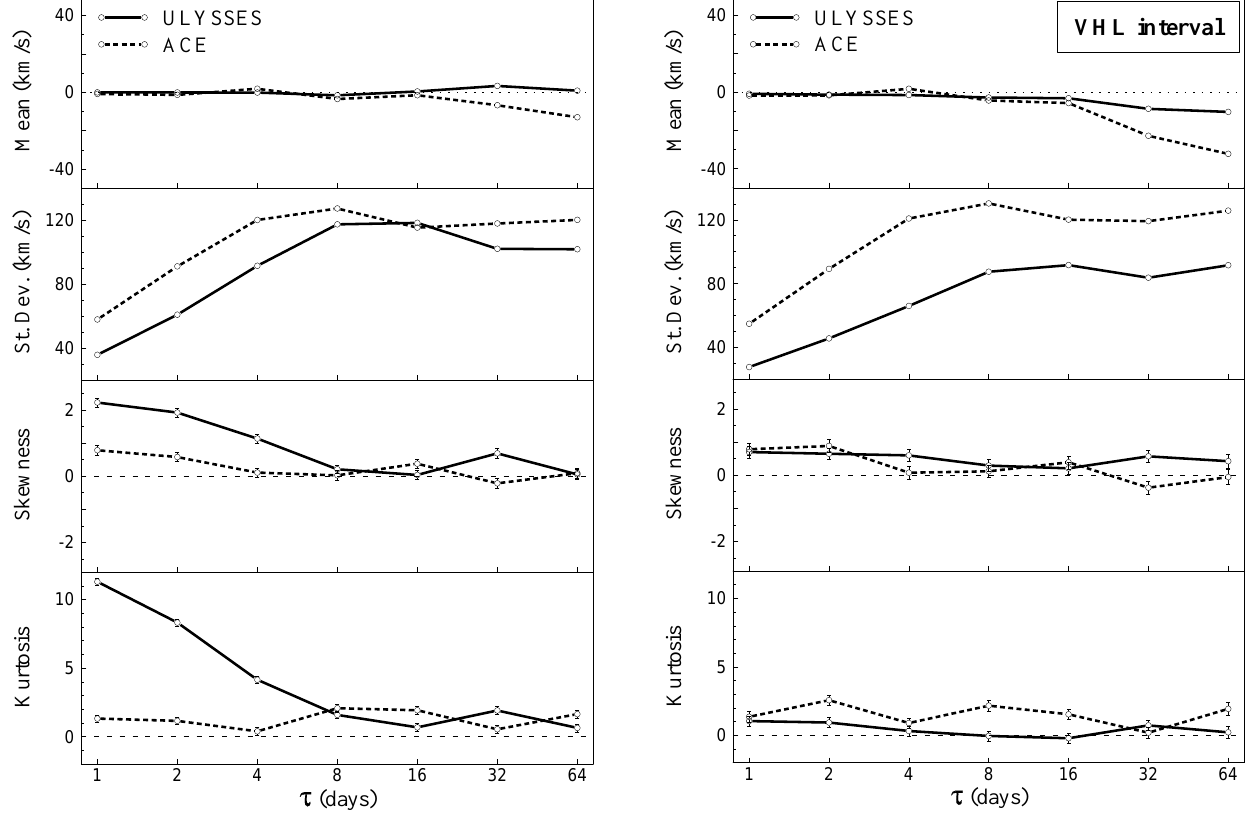
Fig. 7. The dependence of mean, standard deviation, skewness, and kurtosis on the time lag τ is shown separately for Ulysses (solid lines) and ACE (dashed lines) data. Error bars are given for skew- ness and kurtosis (in some cases errors are smaller than the marker size).